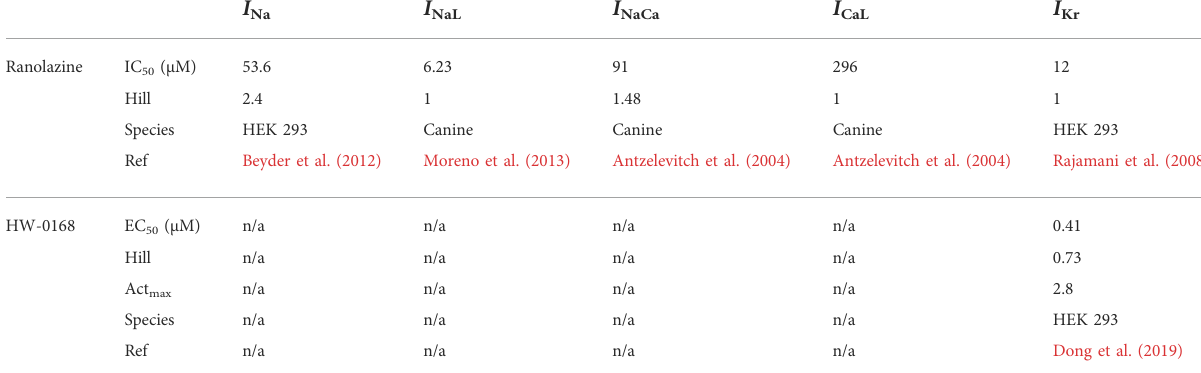
TABLE 1 Summary of data for ranolazine and